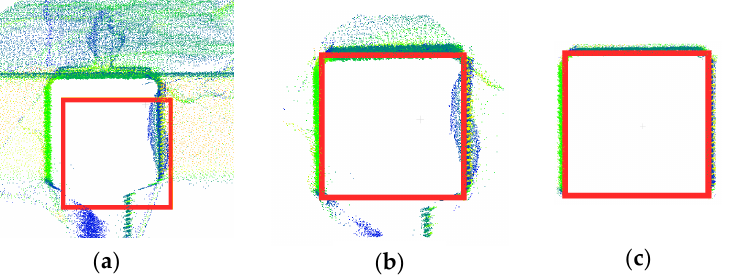
Figure 15. Comparison of Algorithms 1–3 with local implementation of scan vs. BIM: ( a ) sample HSS member (with rounded rectangular edges) and surrounding point cloud with visible local construction error; ( b ) local scan vs. BIM; and ( c ) proposed Algorithms 1–3.